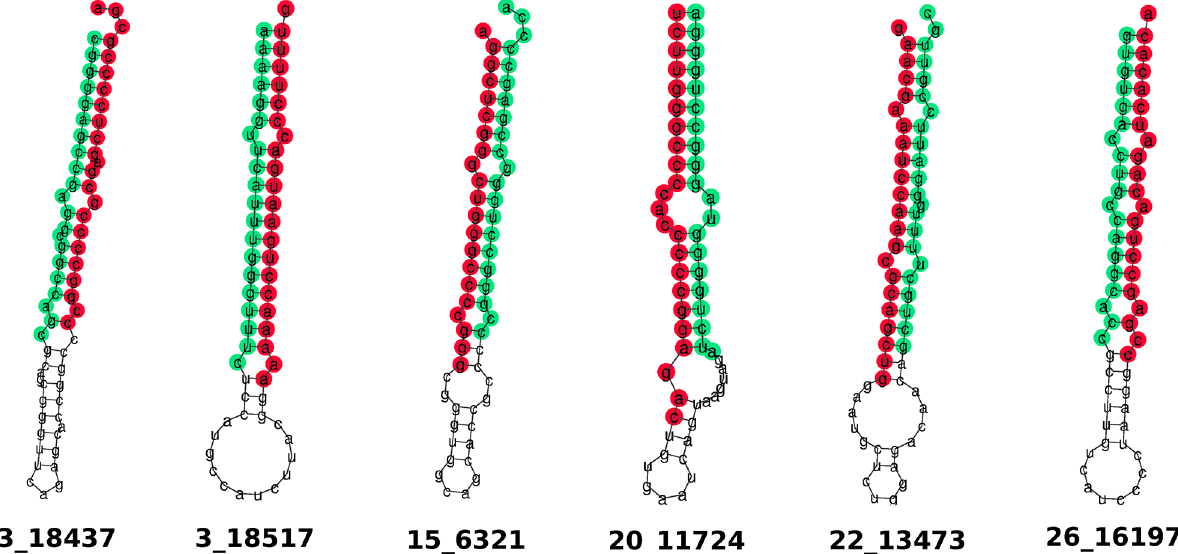
Fig 6. Selected novel miRNAs. Predicted RNA secondary structure of the hairpin for novel micro RNAs. Sequence is coloured according to mature (red) and star (green). Sequences are consensus derived by miRDeep2.